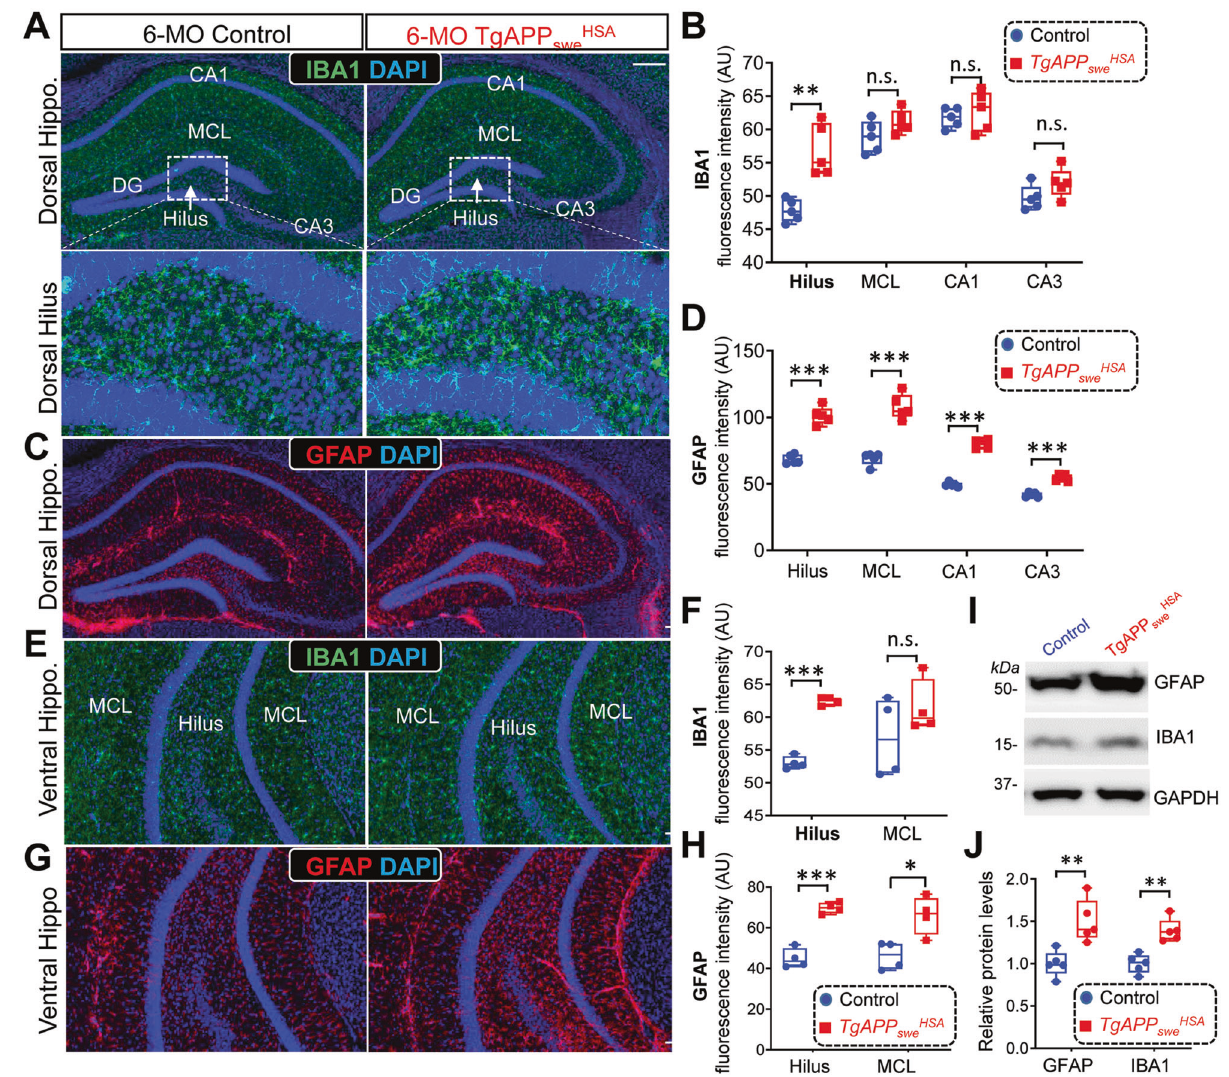
Fig. 2 Elevated hippocampal reactivated astrocytes and microglial cells in 6-MO TgAPP sweHSA mice. A Representative images of co- immunostaining with IBA1 (green) and DAPI (blue) of dorsal hippocampal sections from 6-MO control (LSL-APP swe ) and TgAPP sweHSA mice. B Quanti fi cation of the data in ( A ). C Representative images of co-immunostaining with GFAP (red) and DAPI (blue) of dorsal hippocampal sections from 6-MO control ( LSL-APP swe ) and TgAPP sweHSA mice. D Quanti fi cation of the data in ( C ). E Representative images of co- immunostaining with IBA1 (green) and DAPI (blue) of ventral hippocampal sections from 6-MO control (LSL-APP swe ) and TgAPP sweHSA mice. F Quanti fi cation of the data in ( E ). G Representative images of co-immunostaining with GFAP (red) and DAPI (blue) of ventral hippocampal sections from 6-MO control ( LSL-APP swe ) and TgAPP sweHSA mice. H Quanti fi cation of the data in ( G ). I Representative Western blots using antibodies against GFAP and IBA1 in homogenates of control and TgAPP sweHSA hippocampus. GAPDH was used as a loading